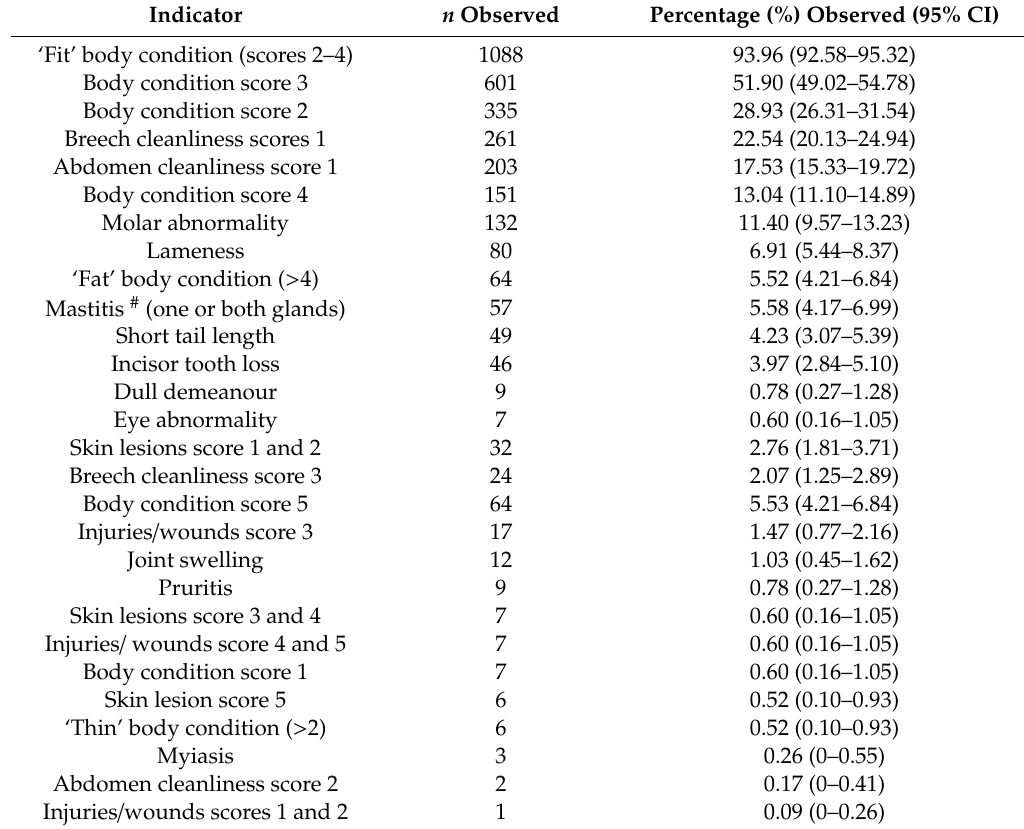
Table 3. Apparent prevalence of sheep health and welfare indicator outcomes (percentage, 95% confidence interval) in descending order as determined by the test standard observer